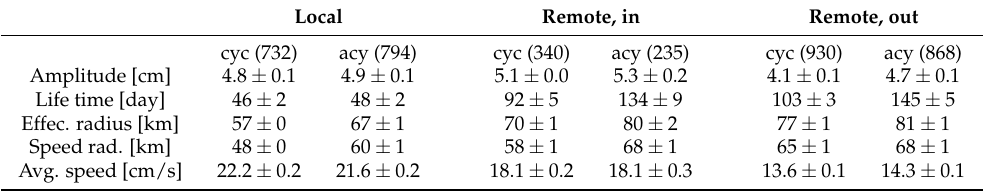
Table 1. Mean and standard error of key properties of compact, closed-contour cyclonic (cyc) and anticyclonic (acy) mesoscale eddies in the South Brazil Bight. The numbers in parenthesis represent the total number of unique eddies identified over the altimetric record (1993–2021), and the statistics are based on averaged properties over each eddy’s lifetime; the statistics only counts eddies with time-averaged amplitude greater than 2.5cm, significantly above the altimeter noise. Local eddies were first observed within the Brazil Current domain, west of the dashed line in Figure 6, while remote eddies were first detected outside the Brazil Current region, east of the the dashed line. Remote-in eddies were eventually detected west of the dashed line; remote-out eddies were never detected west of that line. See Section 2.1 for a description of the eddy properties in the META3.2 DT Eddy Atlas. Local Remote, in Remote, out cyc